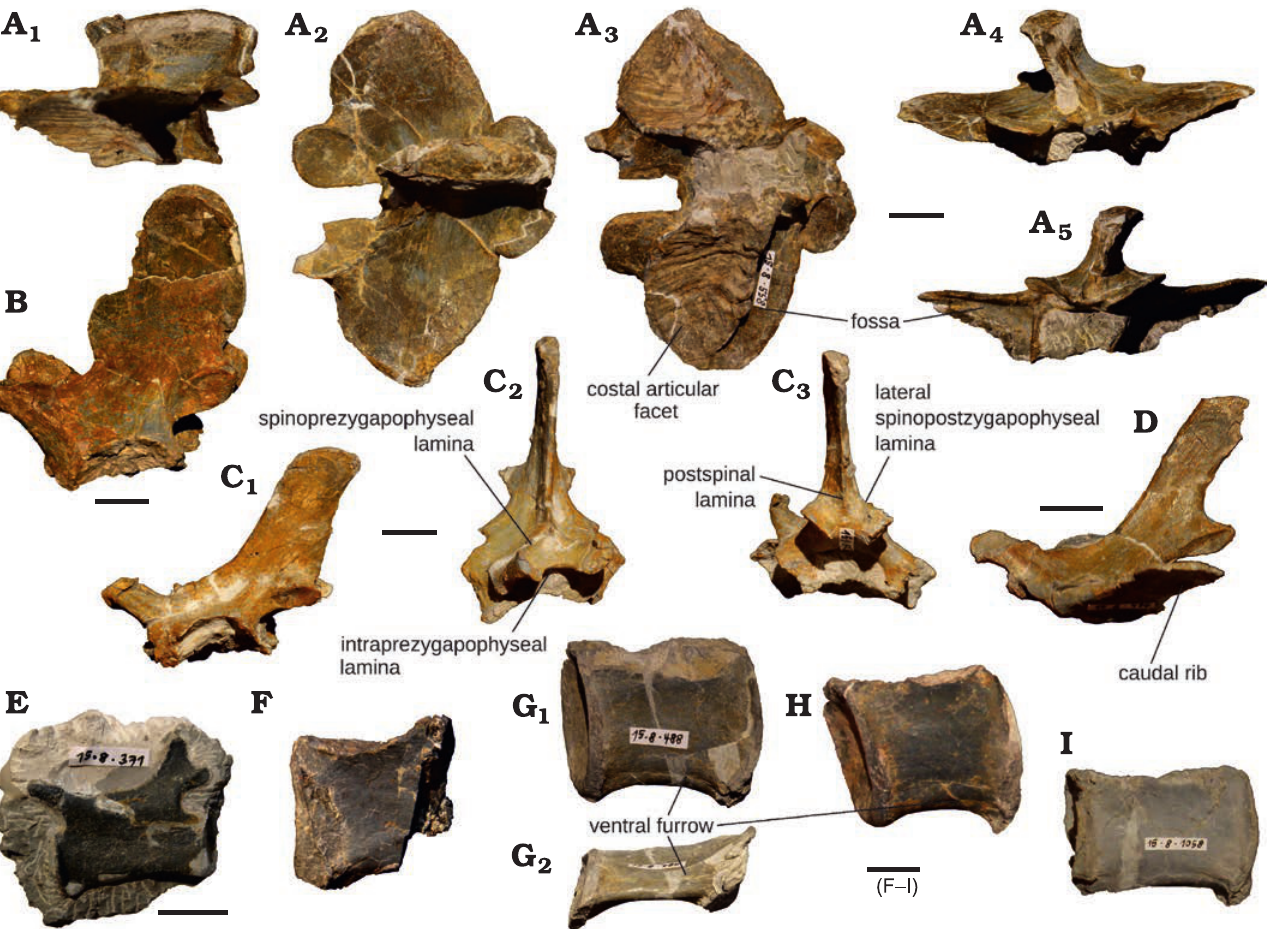
Fig. 5. Sacral and caudal vertebrae of juvenile Plateosaurus cf. trossingensis Fraas, 1913 skeleton MSF 15.8B. from the Norian of Frick, Switzerland. A . Sacral neural arch, MSF 15.8.558, in left lateral (A 1 ), dorsal (A 2 ), ventral (A 3 ), anterior (A 4 ), and posterior (A 5 ) views. B . Anterior caudal neural arch, MSF 15.8.889, in left lateral view. C . Mid-caudal neural arch, MSF 15.8.972, in left lateral (C 1 ), anterior (C 2 ), and posterior (C 3 ) views. D . Mid-caudal neural arch, MSF 15.8.476, in left lateral view (note fused transverse process). E . Distal caudal vertebra, MSF 15.8.371 (note closed neurocentral suture), in left lateral view. F . Proximal caudal centrum, MSF 15.8.2008, in lateral view. G . Proximal caudal centrum, MSF 15.8.488, in lateral (G 1 ) and ventral (G 2 ) views. H . Proximal caudal centrum, MSF 15.8.975, in lateral view. I . Mid-caudal centrum, MSF 15.8.1058, in lateral view. Scale bars 10